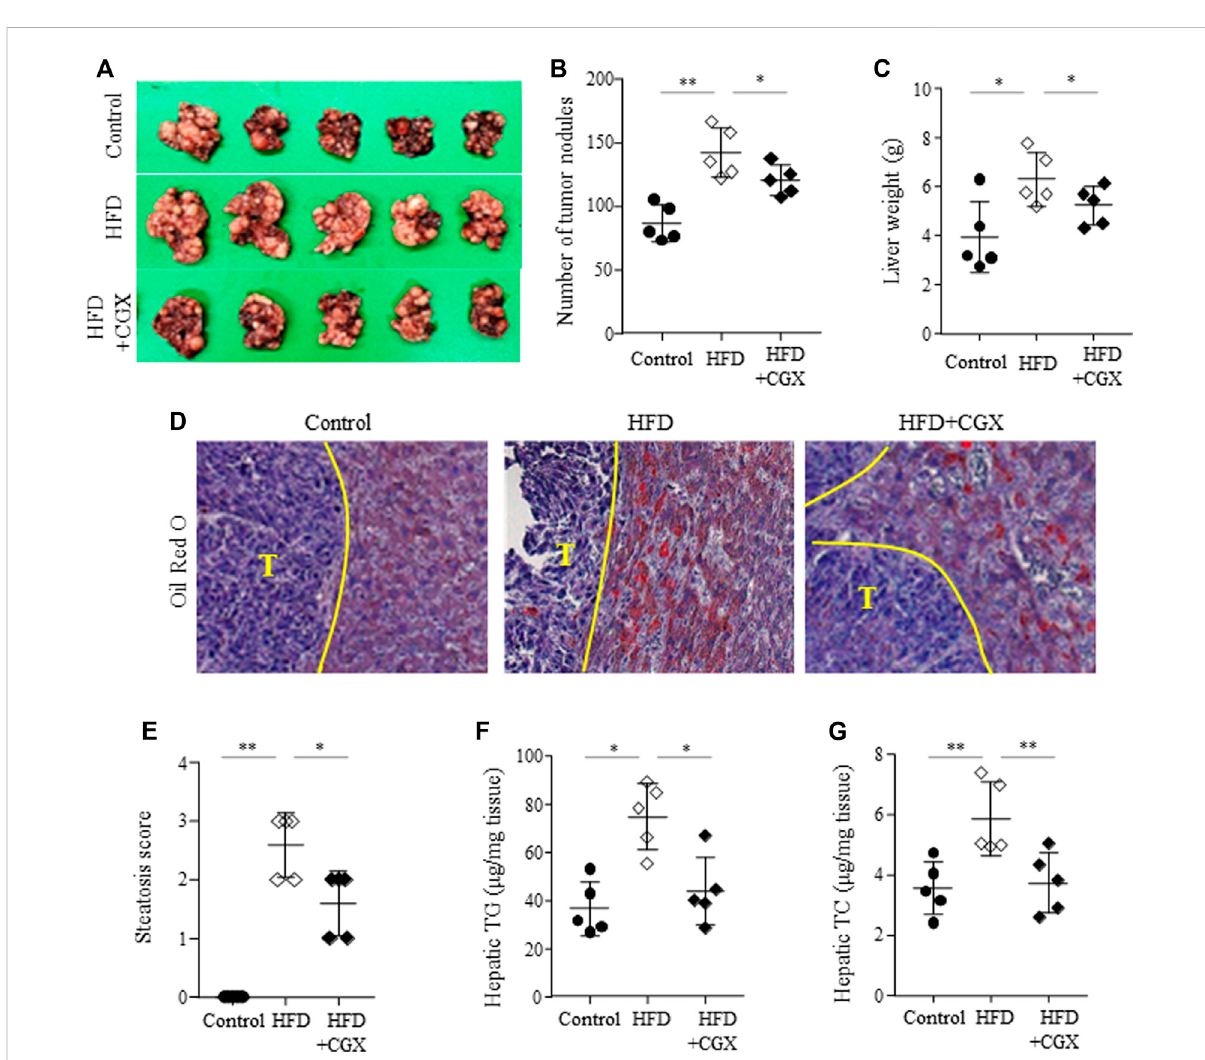
FIGURE 5 Effects of anti-metastatic effects of CGX in the HFD-induced metastasis model. Beginning 2 weeks after HFD feeding, the mice were orally administered water or CGX (400 mg/kg) for 14 days. A splenic injection of MC38 cells (1 × 10 5 /mouse) was performed on the day of the fi nal administration of CGX. The liver weights and numbers of nodules were evaluated by two researchers who were blinded to group allocations (A – C) . Oil red O staining was performed in the liver tissue and visualized at ×200 magni fi cations (D) . Steatosis area was scored according to the nonalcoholic steatohepatitis (NASH) clinical research network scoring system (E) . Hepatic TG and TC were determined using common kits (F) and (G) . The data are expressed as the means ± SD ( n = 5). * p < 0.05 or ** p < 0.01 indicates statistical signi fi cance compared to each group. T; Tumor